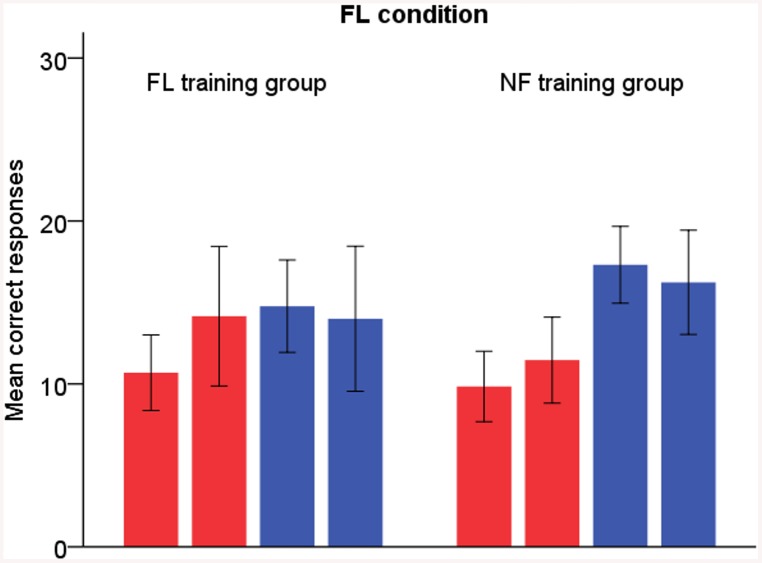
FL condition.Red bars = left-ear responses, blue bars = right-ear responses. The left-sided bar of each two bars of the same colour represents pre-training results and the right-sided bar post-training results. Error bars display 95% confidence interval for mean.